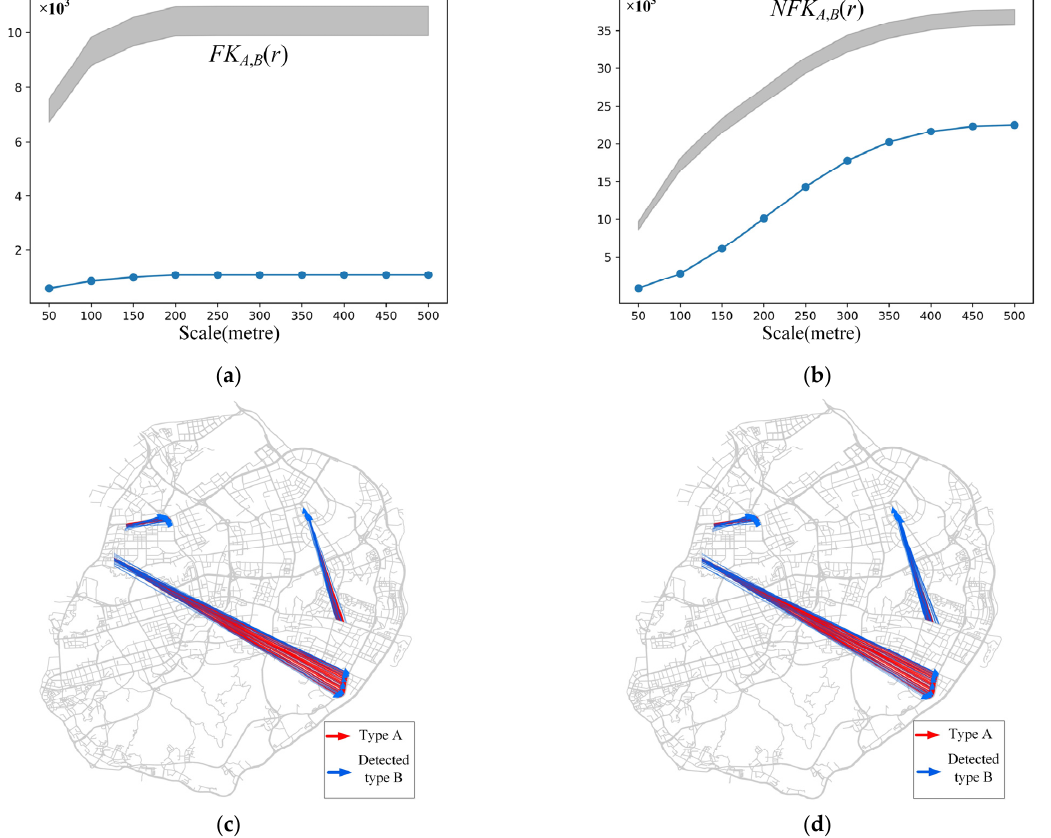
Figure 4. Results of the four methods: ( a ) Flow Cross K-Function; ( b ) Network-Constrained Flow Cross K-Function; ( c ) Flow Cross K-Function (83 detected type B spatial flows); ( d ) Geographically Weighted Flow Cross K-Function (115 detected type B spatial flows).